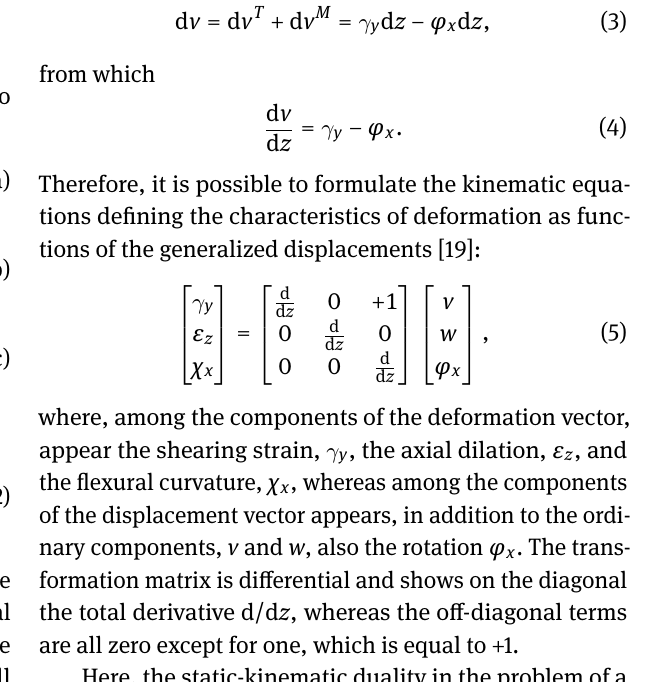
Figure 3: Beam with rectilinear axis